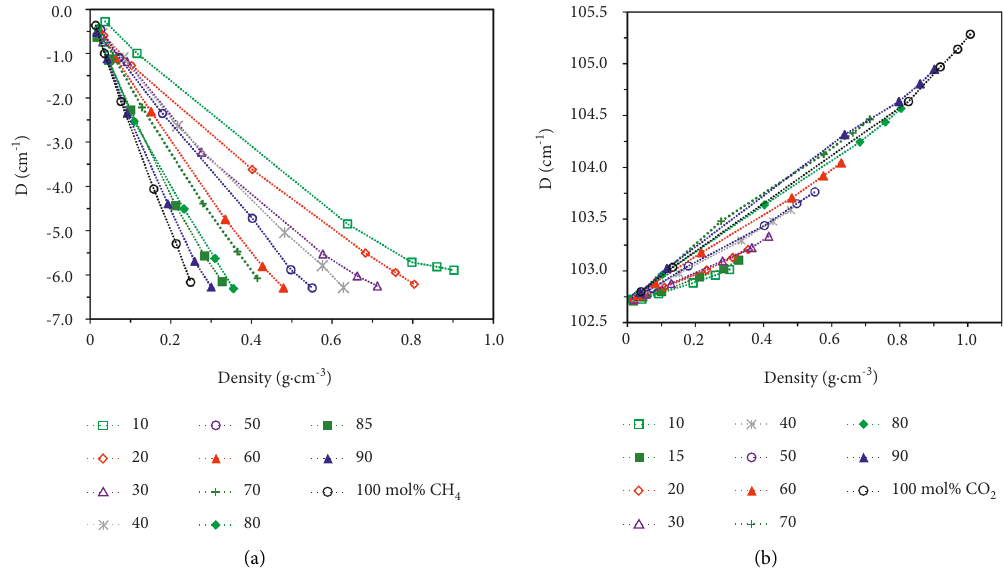
(b) within CO 2 -CH 4 gas mixtures as a function of density and composition. D Δ